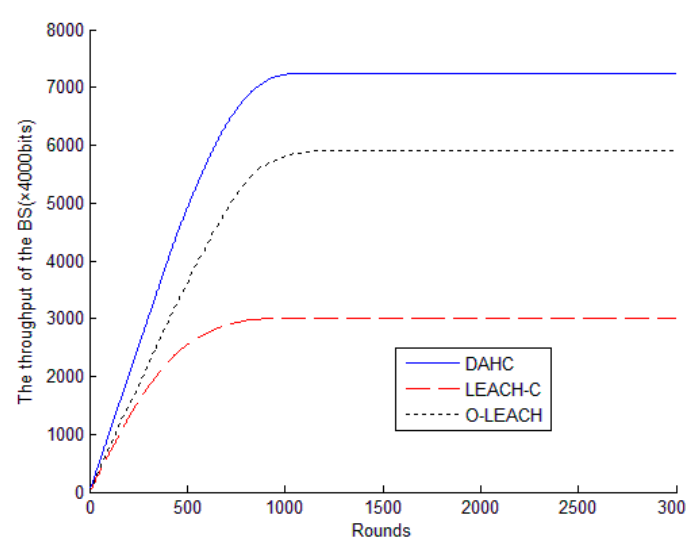
Figure 9. The throughput of the BS when it is inside.